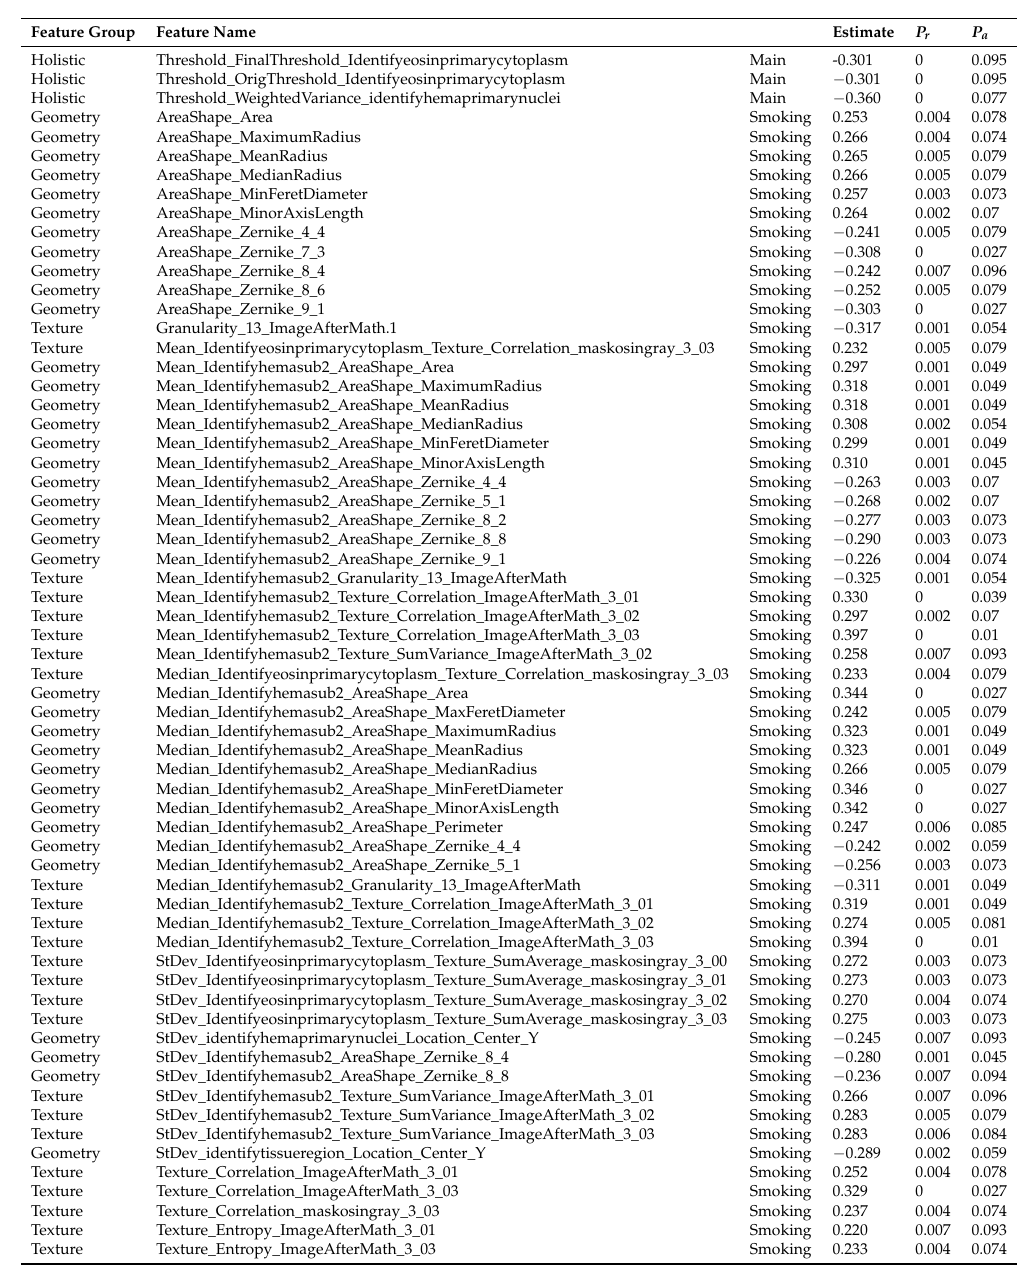
Table 3. Marginal analysis of overall survival: identified main effects and interactions, with raw p -values P r and false discovery rate (FDR) adjusted p -values P a